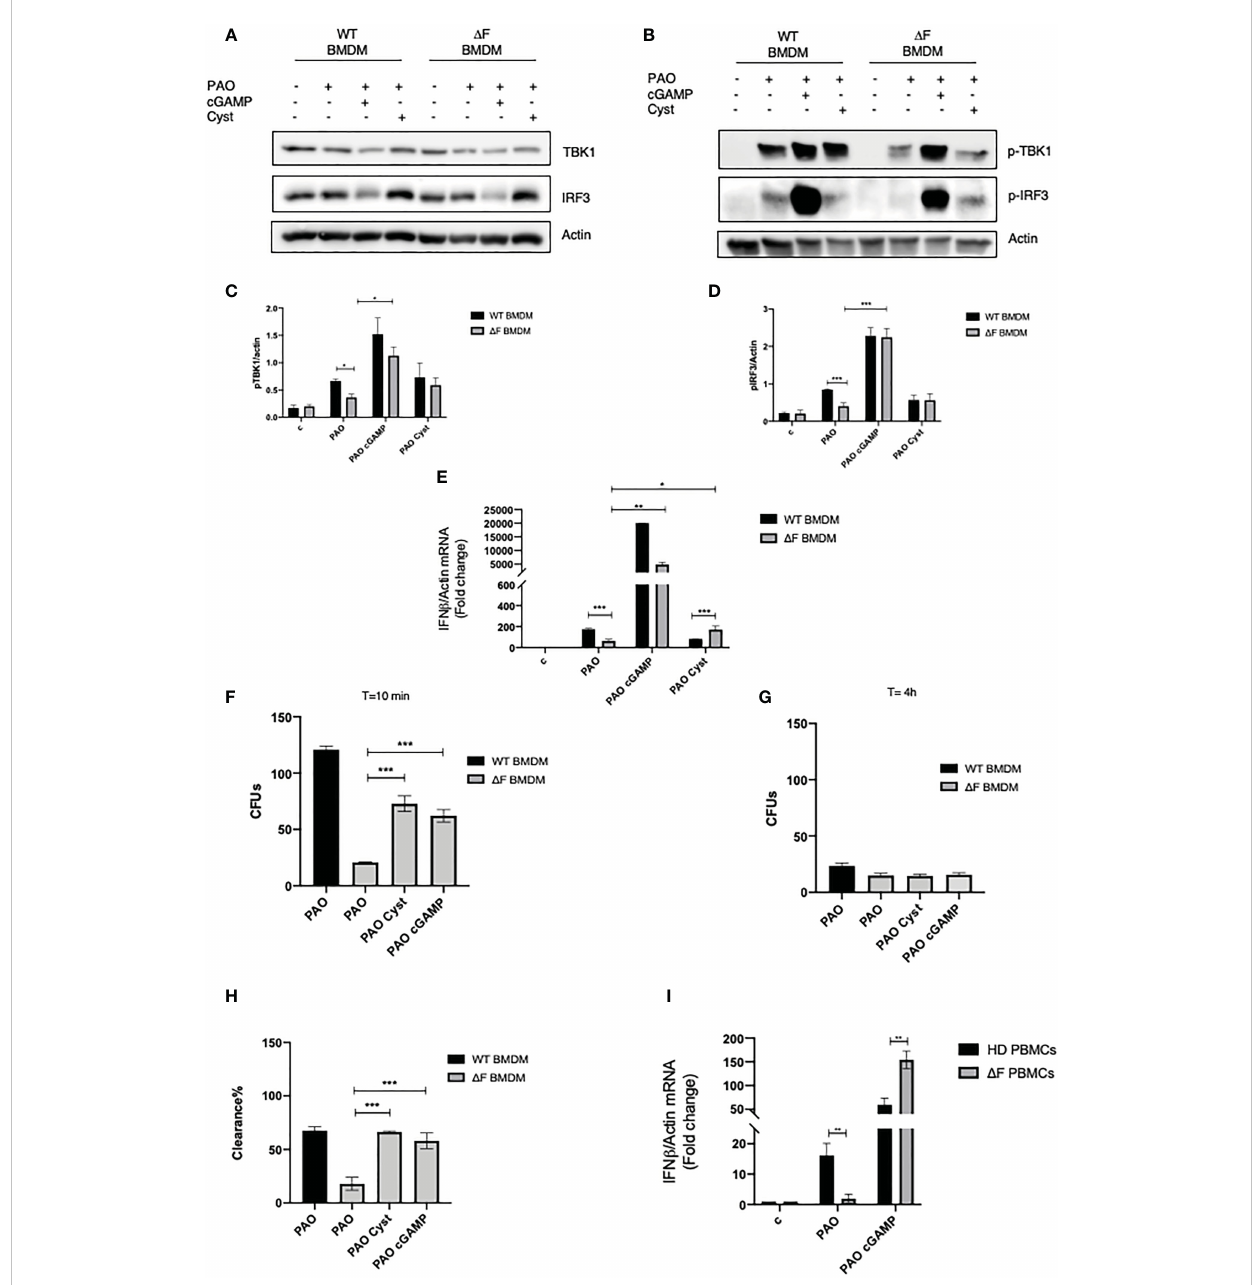
FIGURE 2 2 ’ ,3 ’ cGAMP restores the STING axis in D F ex vivo models (A) Western blot analysis of TBK1 and IRF3, and their phosphorylated forms (B) , with their respective densitometric analysis (C, D) , in PAO-1 infected WT and D F BMDMs, following overnight cysteamine treatment and 2h of 2 ’ ,3 ’ cGAMP stimulation. Actin was used to normalize protein loading levels. (n=3; means ± SEM; *p<0.05; ***p<0.001). (E) IFN- b mRNA levels, quanti fi ed by qPCR, in WT and D F BMDMs treated with cysteamine and 2 ’ ,3 ’ cGAMP. Actin mRNA levels were used to normalize IFN- b mRNA levels (n=3; means ± SEM; ***p<0.001). (F) PAO-1 internalization at T=10 expressed as number of CFUs. (G) Living PAO-1 after 4 hours expressed as number of CFUs. (H) Percentage of PAO-1 clearance expressed as living bacteria after 4 hours of culture with respect to internalized bacteria. (n=3; means ±